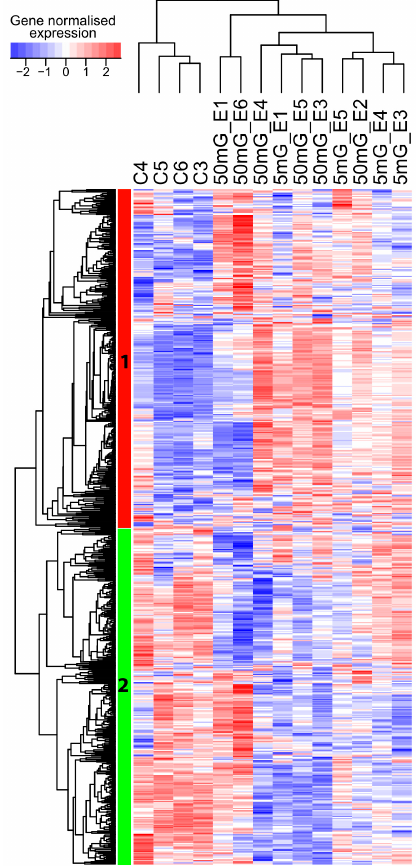
Figure 5. Heat map of normalised expression of 600 genes with a hypomethylated promoter (DMR < 500 bp from TSS) at 50 mGy/h (50 mG), 5 mGy/h (5 mG) and control (C). Biological replicates in each condition are displayed. Blue: low expression, white: moderate expression and red: high expression.